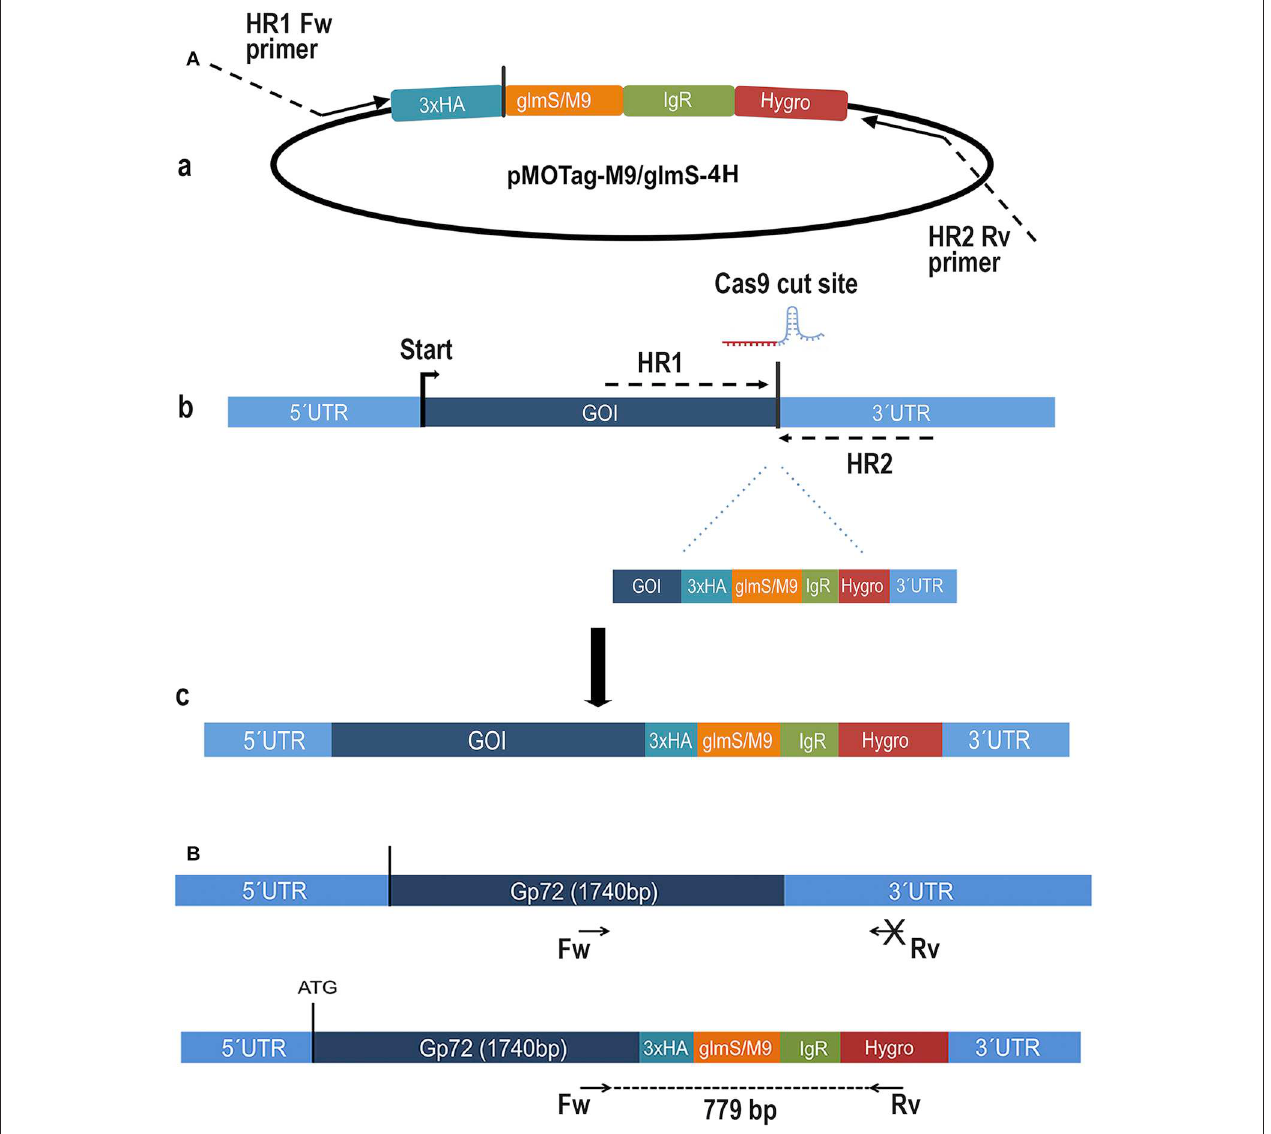
FIGURE 1 | Schematic representation of the strategy used in Trypanosoma cruzi . (A) (a) pMOTag-4H-M9/glmS vector map. HR1 Fw, and HR2 Rv, ultramers indicate oligonucleotides used to amplify the DNA donor. (b) A doubled strand break was produced in the gDNA by Cas9 targeted by the sgRNA downstream of the STOP codon of the gene of interest (GOI), both expressed from 3 ′ end-sgRNA/Cas9/pTREX-n plasmid. Homologous directed repair was induced co-transfecting epimastigotes with the DNA donor cassette, containing homologous regions to the GOI 3 ′ end (dark blue) and to the GOI 3 ′ UTR (light blue). (c) Integration of 3xHA, M9/glmS and antibiotic resistance genes at 3 ′ end of GOI by homologous recombination. (B) Diagram representing the positions of the primers (arrows) used to verify the integration of the donor DNA at the 3 ′ end of TcGP72 ORF.